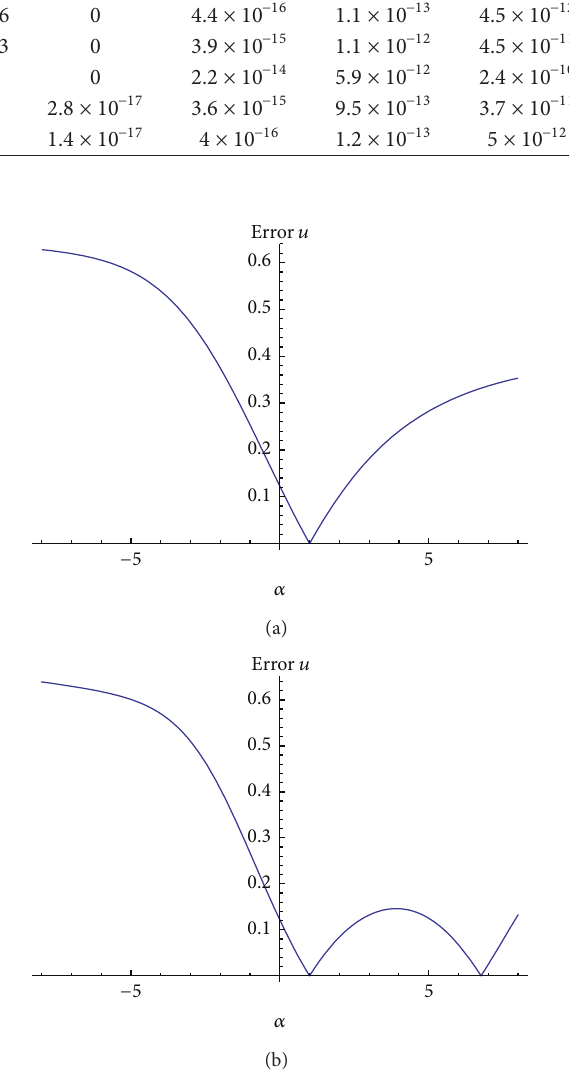
(1,0.1)| , (b) absolute app